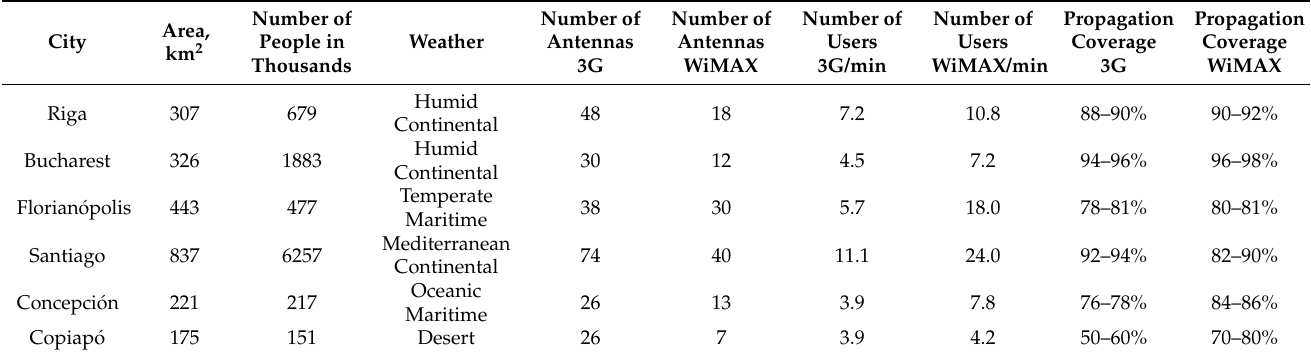
Table 1. Summary of involved project